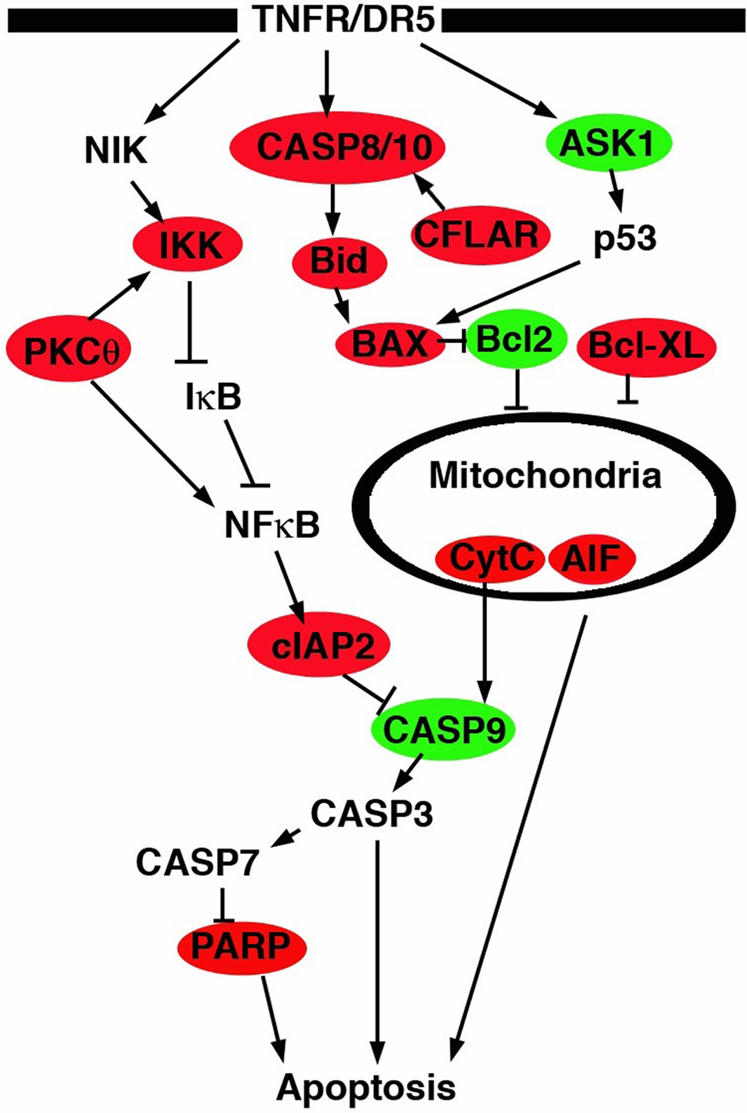
Apoptosis pathway with genes displaying increased expression (colored red) and decreased expression in carcinoma-like samples (colored green).Carcinoma-like samples had higher expression of pro-apoptotic genes such as BAX, BID, CASP8, and AIF. These samples also expressed higher levels of anti-apoptotic factors such as IKK, Bcl-xl, and c-IAP2. Adenoma-like samples had higher Bcl-2 expression than carcinoma-like samples.